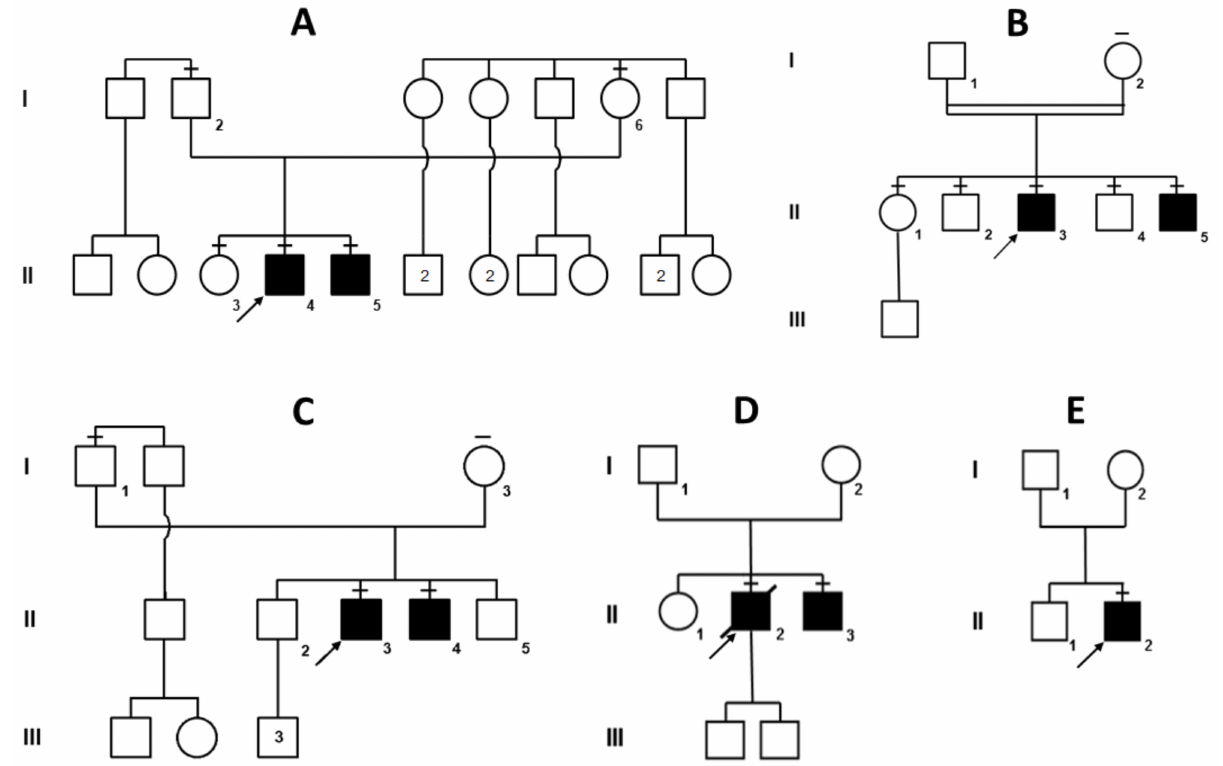
Figure 1. Pedigrees of the five choreo-acanthocytosis families ( A–E ), all with a clear recessive mode of inheritance. However, consanguineity was confirmed only for pedigree B (parents are second-degree cousins) and suspected for pedigree D (both parents carry the same VPS13A variant). Affected individuals are shaded in black. Family members that were sequenced are indicated by a dash on top of their